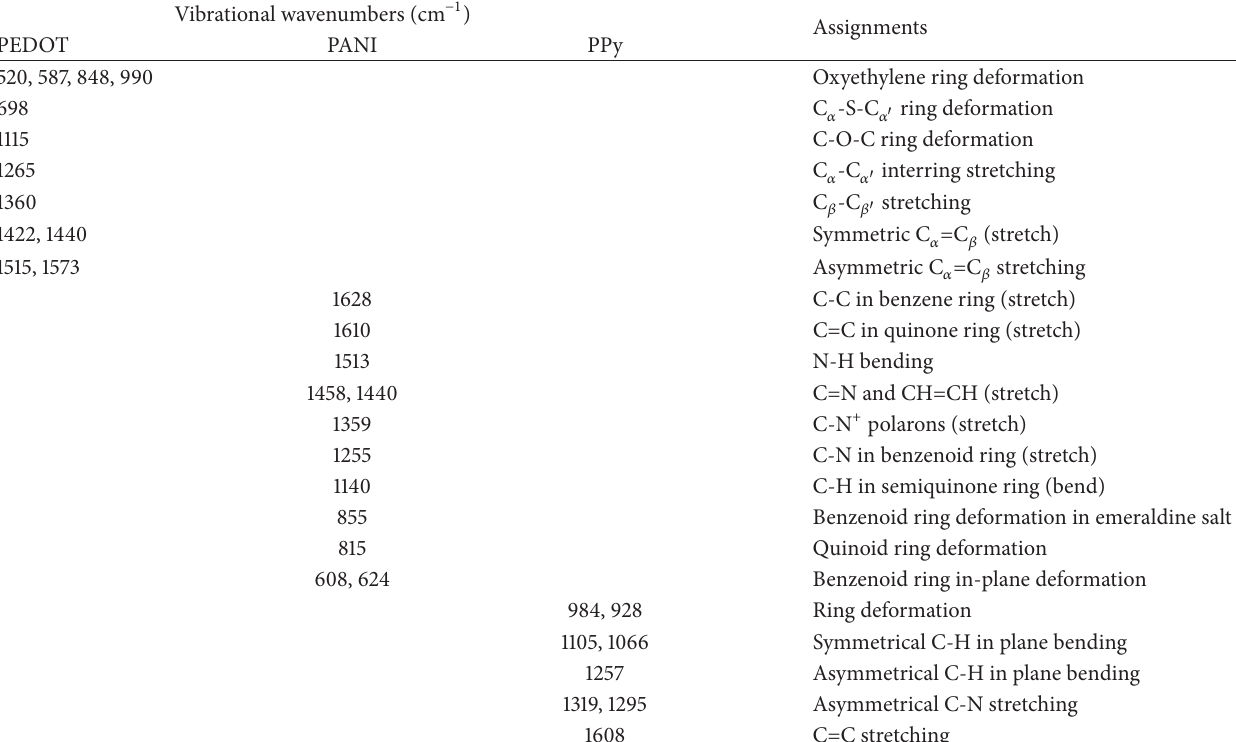
Table 2: Assignments of the Raman bands for the PEDOT, PANI, and